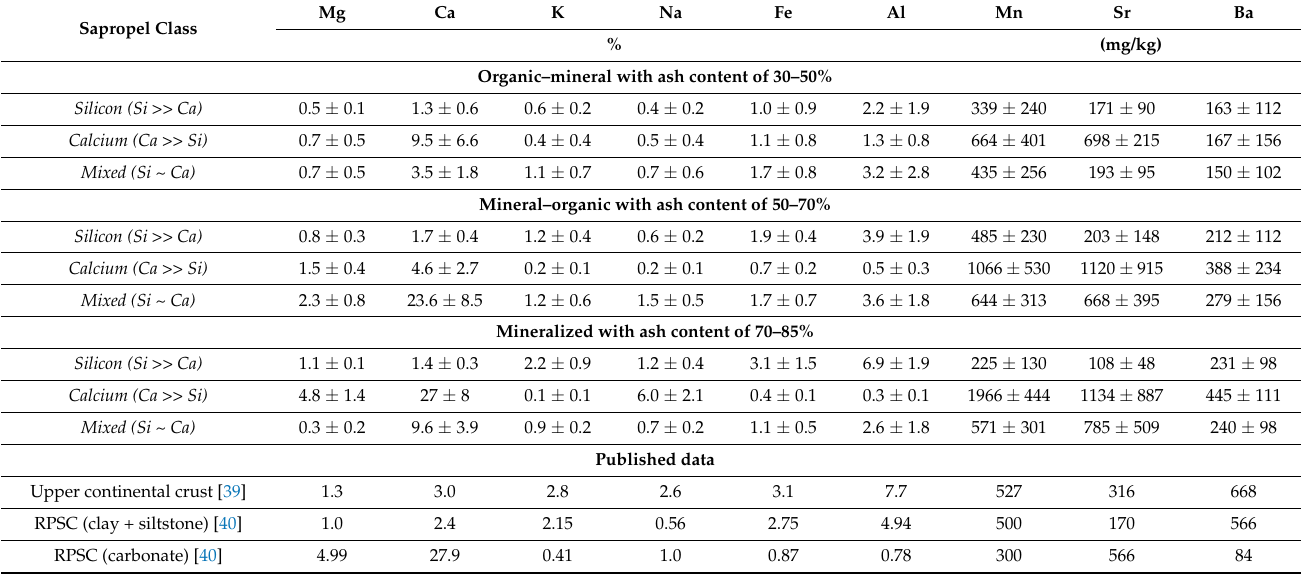
Table 1. Average content of major (%) and trace elements (mg/kg) in sapropels of lakes of various types and classes in the south of Western Siberia (arithmetic mean ± standard deviation).